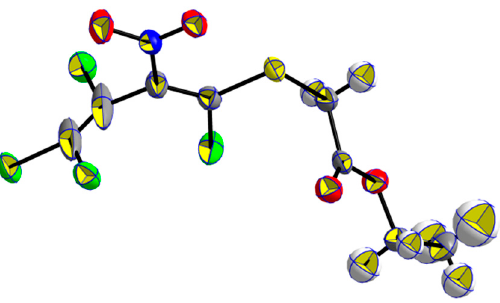
Figure 2. X-ray single-crystal structure of ethyl ( E )-2-((1,3,4,4-tetrachloro-2-nitrobuta-1,3-dien-1- yl)thio)acetate ( 3a ). yl)thio)acetate ( 3a